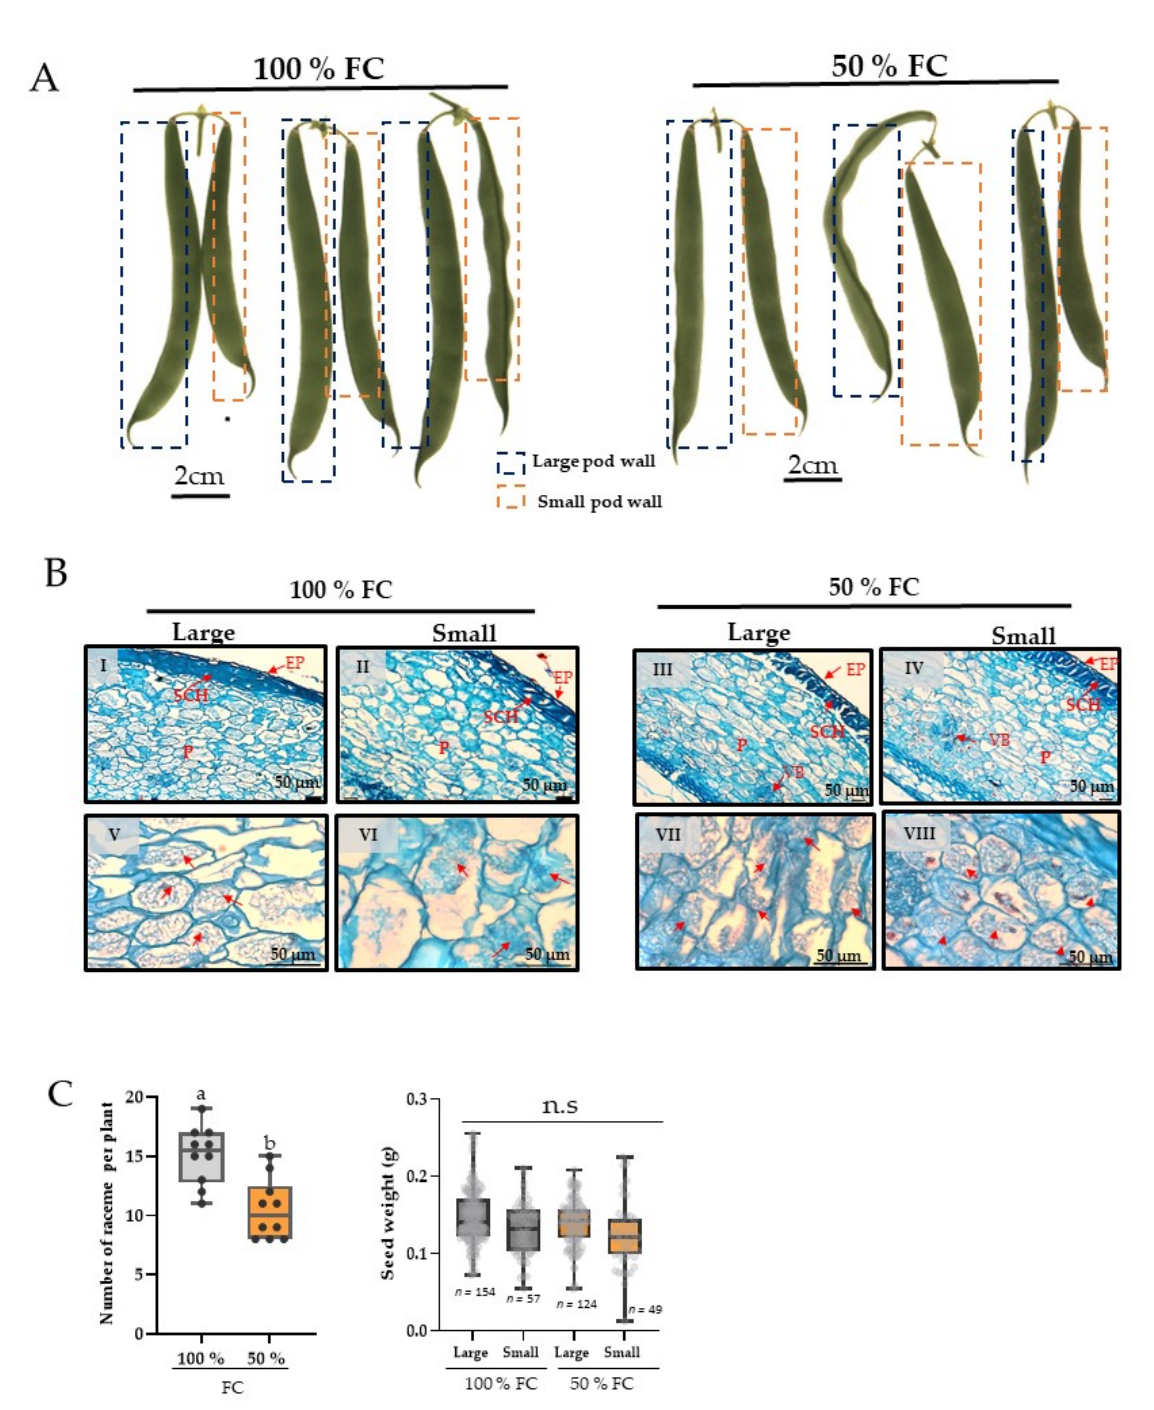
Figure 2. ( A ) Examples of pod racemes with large and small fruits from plants at 100% field capacity (FC) and under water restriction (50% FC) for 10 d. ( B ) Anatomical characteristics of walls of large and small pods developed in common bean plants with soil at 100% field capacity (FC) and after 10 days at 50% FC. ( I – IV ): pericarp cross-sections (10× objetive); (( V – VIII ); light micrographs (40× objetive) showing starch granules in parenchyma (P) (red arrows). Epidermis (EP), sclereid hypodermis (SCH), vascular bundles (VB). ( C ) Racemes per plant harvested after 10 d; n = 10. Left graph. Seed weight ( ± S.E.) distribution in large and small pods. Right graph, from plants at 100% FC (gray) and 50% FC (orange); n = 5. Boxes marked with a different letter were significantly different ( p < 0.05) when analyzed by Student’s t test. n.s = not significant.